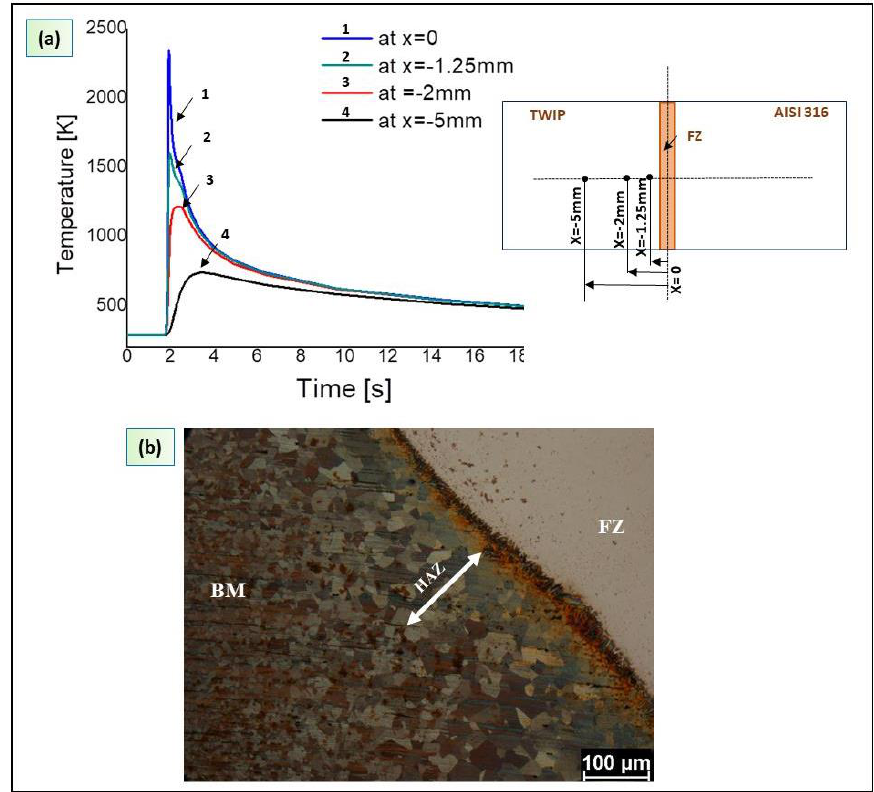
Figure 12. ( a ) Thermal cycles in different points of TWIP steel along the x direction; ( b ) grain coarsening in HAZ and fine austenitic microstructure in the base material.